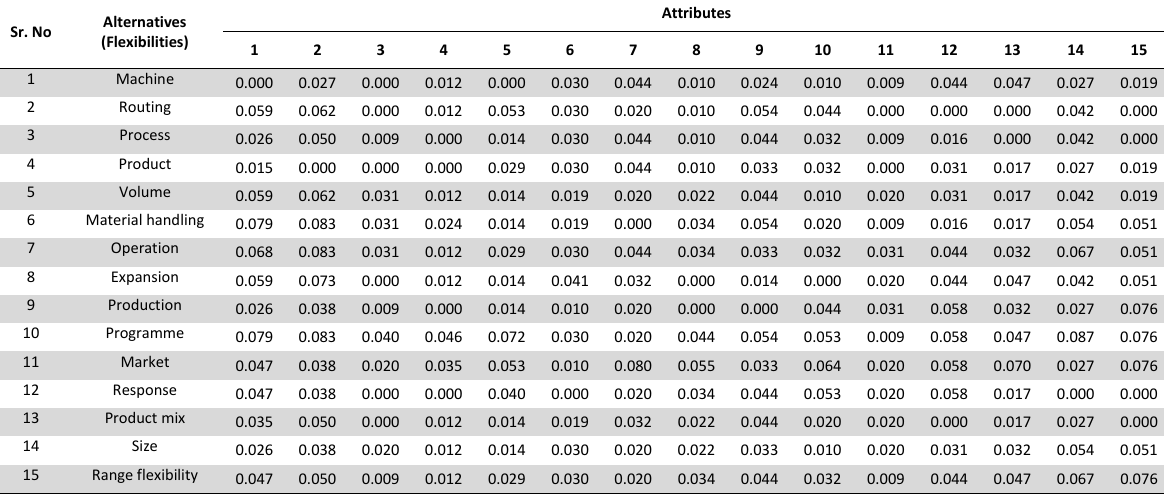
Deviation from reference point of the